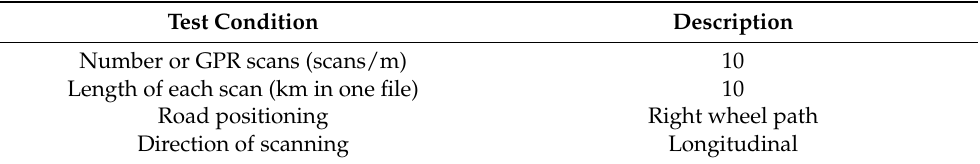
Table 3. Ground Penetrating Radar (GPR) test